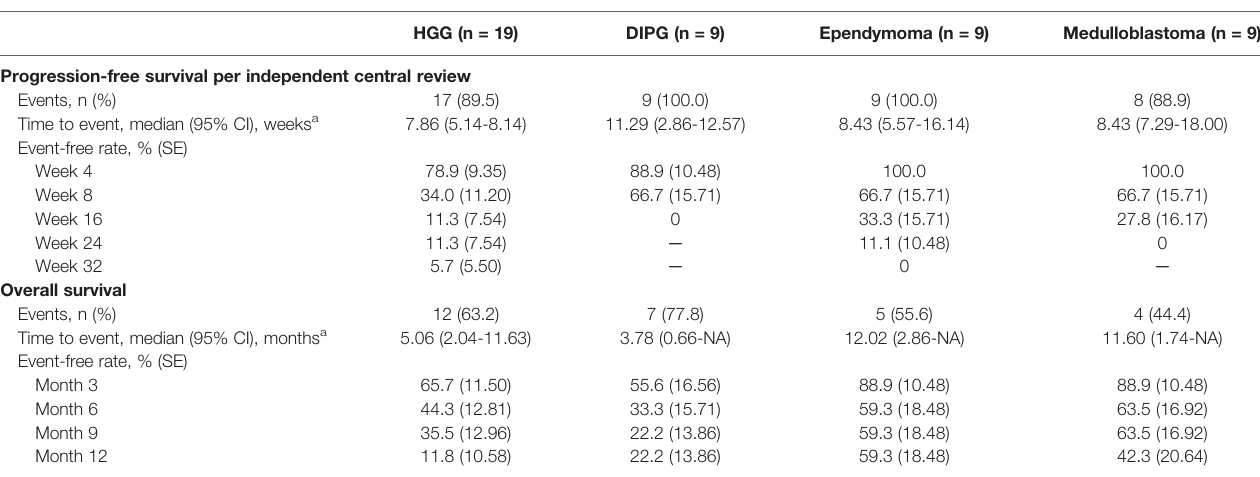
TABLE 3 | Progression-Free Survival and Overall Survival (response population).